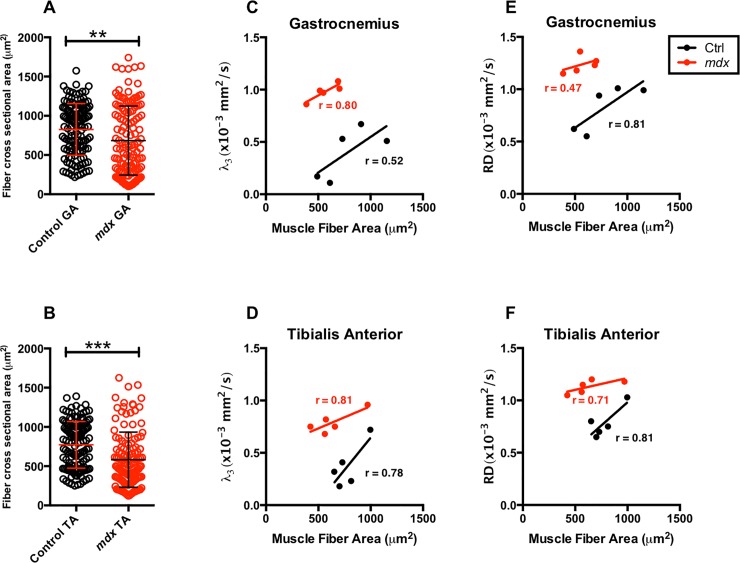
Average muscle fiber area, and λ3 versus average muscle fiber area for TA and GA muscles.Individual muscle fiber areas were measured for the TA and GA muscles and then averaged for comparison between groups. Mdx4cv mice exhibit significantly reduced average individual muscle fiber area for both TA and GA muscles. This data was then plotted against the λ3 values for correlation of diffusivity across single muscle fibers and average fiber size. *P ≤ 0.05, **P ≤ 0.01, ***P ≤ 0.001, and ****P ≤ 0.0001.